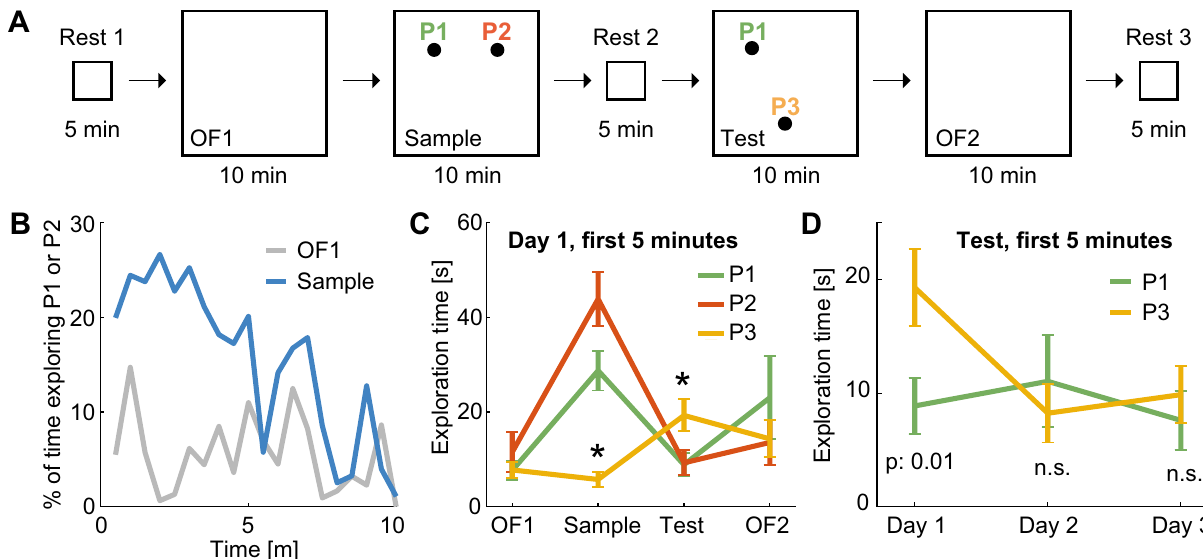
Figure 4. Degus preferentially explore objects introduced in novel positions. ( A ) Diagram of consecutive sessions in the novel object location experiment. Identical objects are introduced in a familiar environment in positions P1 and P2 in the Sample session and in positions P1 and P3 in the Test session. ( B ) Percentage of consecutive 30 s windows exploring positions P1 or P2 during the OF1 (grey) and Sample (blue) sessions (Wilcoxon test for difference during first 5 m z: 3.7, p: 2 10 –4 ). ( C ) Overall exploration time around P1, P2